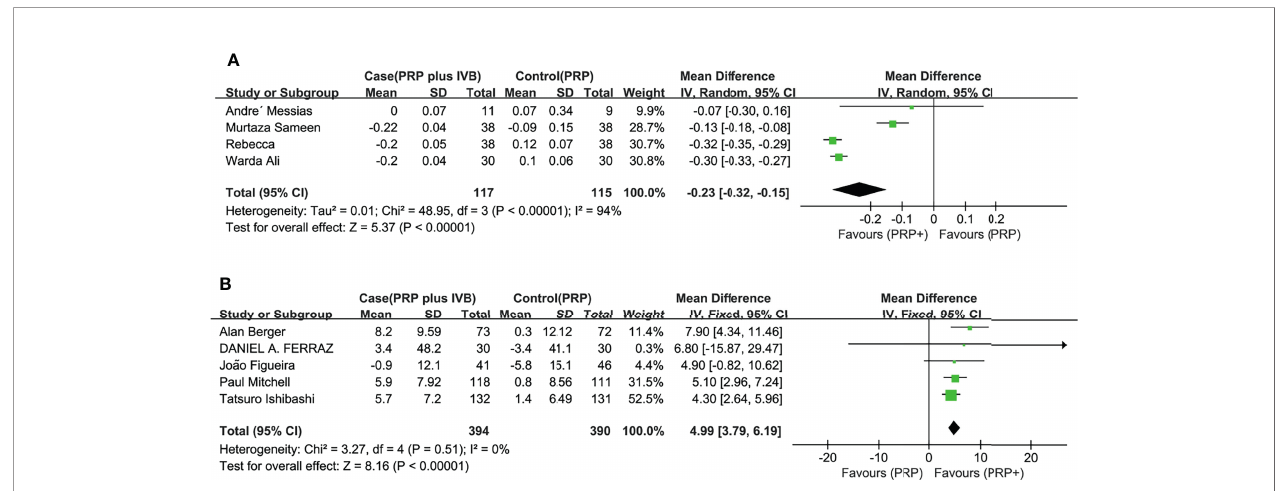
FIGURE 3 | Meta-analyses of PRP+anti-VEGF treatment and PRP monotherapy, comparing changes of BCVA (logMAR, letters). (A) BCVA (logMAR), (B) BCVA (letters). Outcomes assessed: BCVA in studies that compared combination treatment with PRP monotherapy. The shaded area is the weight of the estimate in proportion to the overall